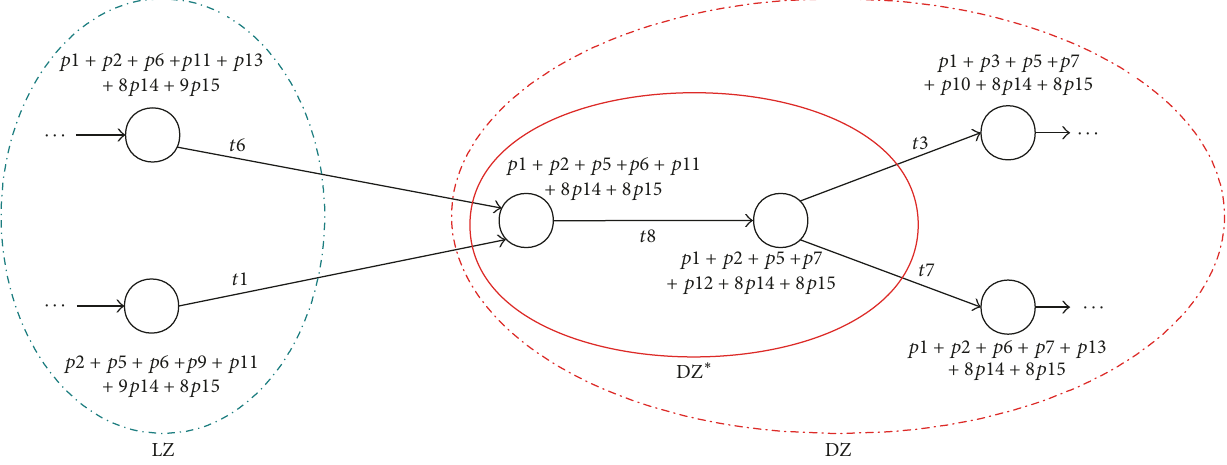
Figure 2: Simulation results in Figure 1 in the case of 𝑀 0 (𝑝 10 ) = 𝑀 0 (𝑝 11 ) = 1 .